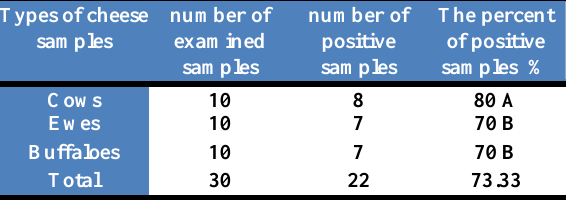
Table, 2: The prevalence of Staphylococcus aureus in bovine and ovine soft cheese samples that